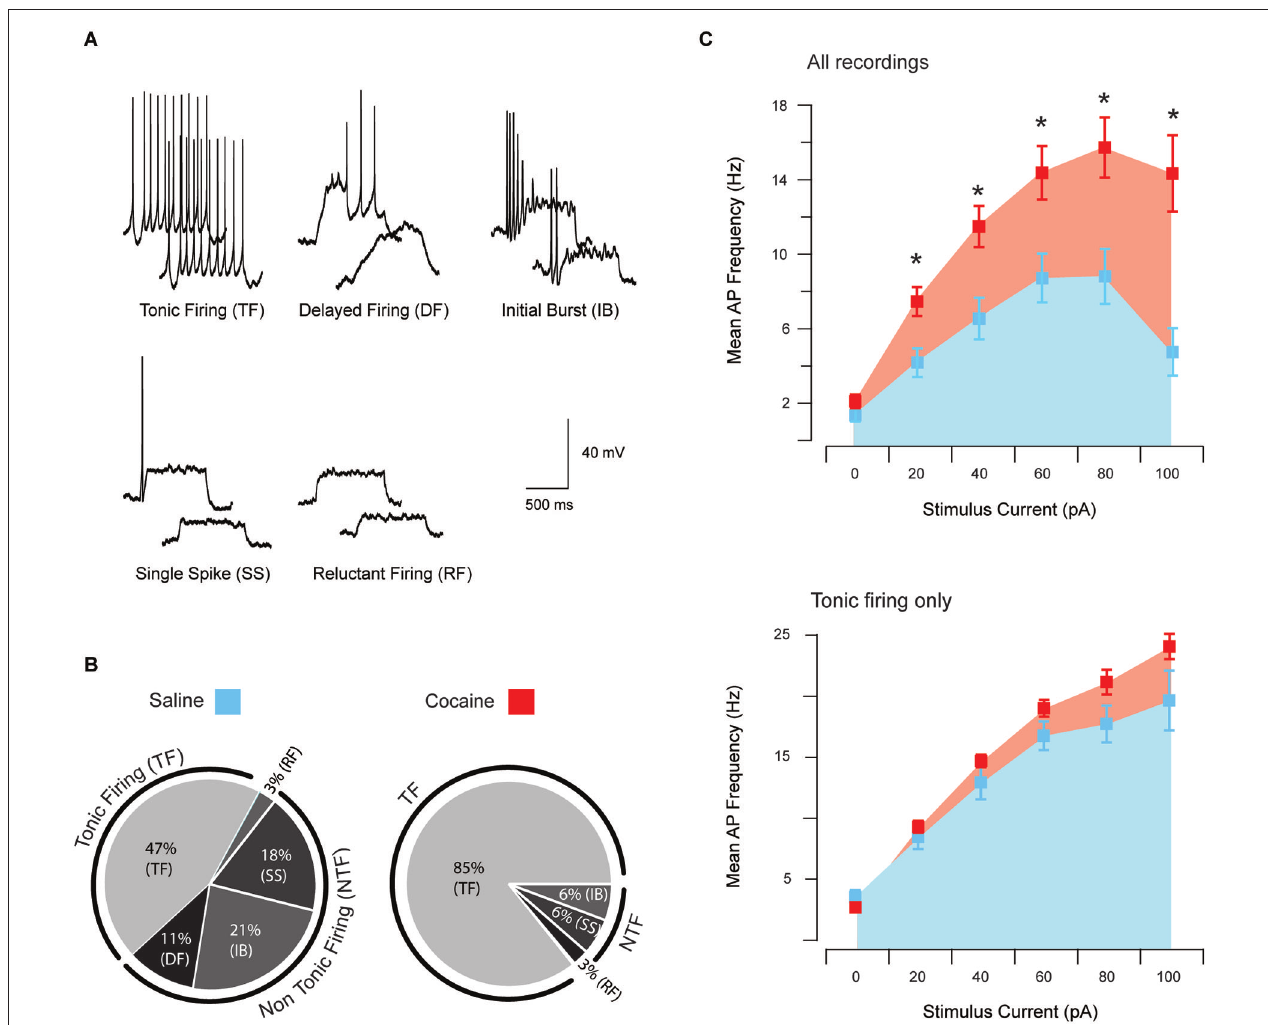
patterns, with 85% exhibiting TF, 3% RF, 6% SS and 6% IB (B, right) . A chi-squared analysis revealed a significant interaction between cocaine treatment and firing pattern type, χ 2 (4, n = 73) = 13.53, p = 0.009. Recordings from cocaine-exposed animals reached higher mean AP discharge frequency at all current step injections above 20 pA (C, upper) . In contrast, the same comparison of AP discharge frequency, specifically in tonic firing PVT neurons from both treatment groups, did not differ (C, lower)